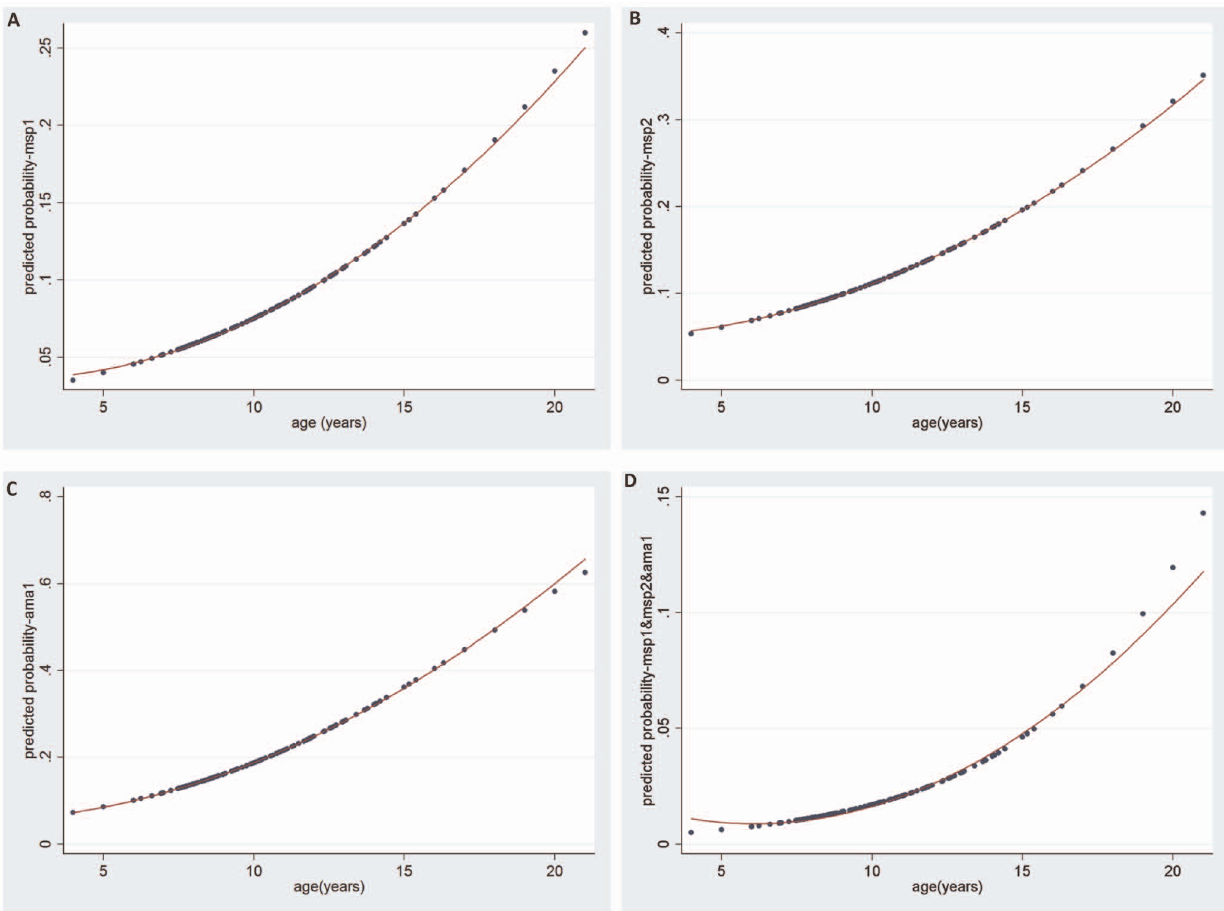
Figure 1. Age-specific seroprevalence. A. MSP1 19 . B. MSP2. C. AMA1. D. MSP1 19 , MSP2 and AMA1(combined).